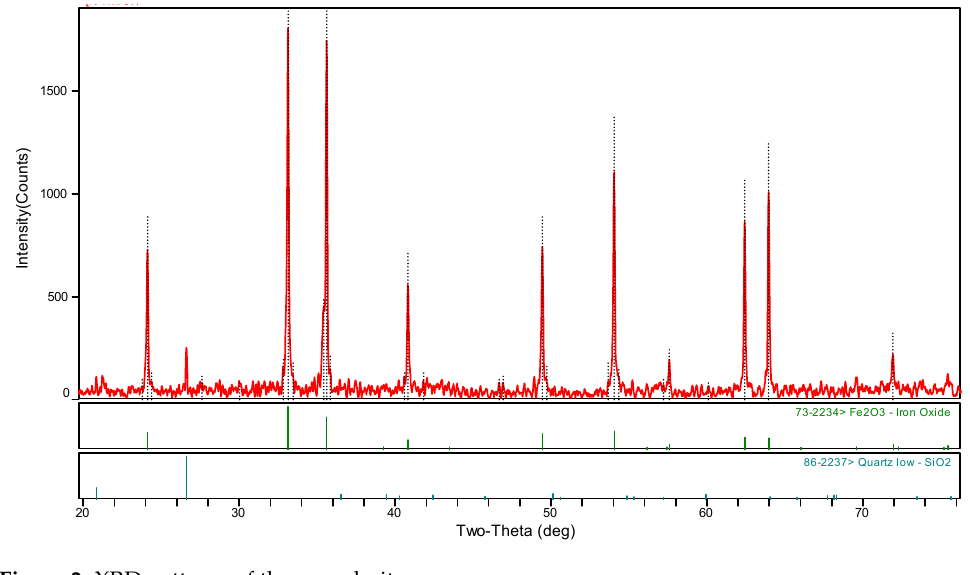
Figure 2. XRD patterns of the specularite.